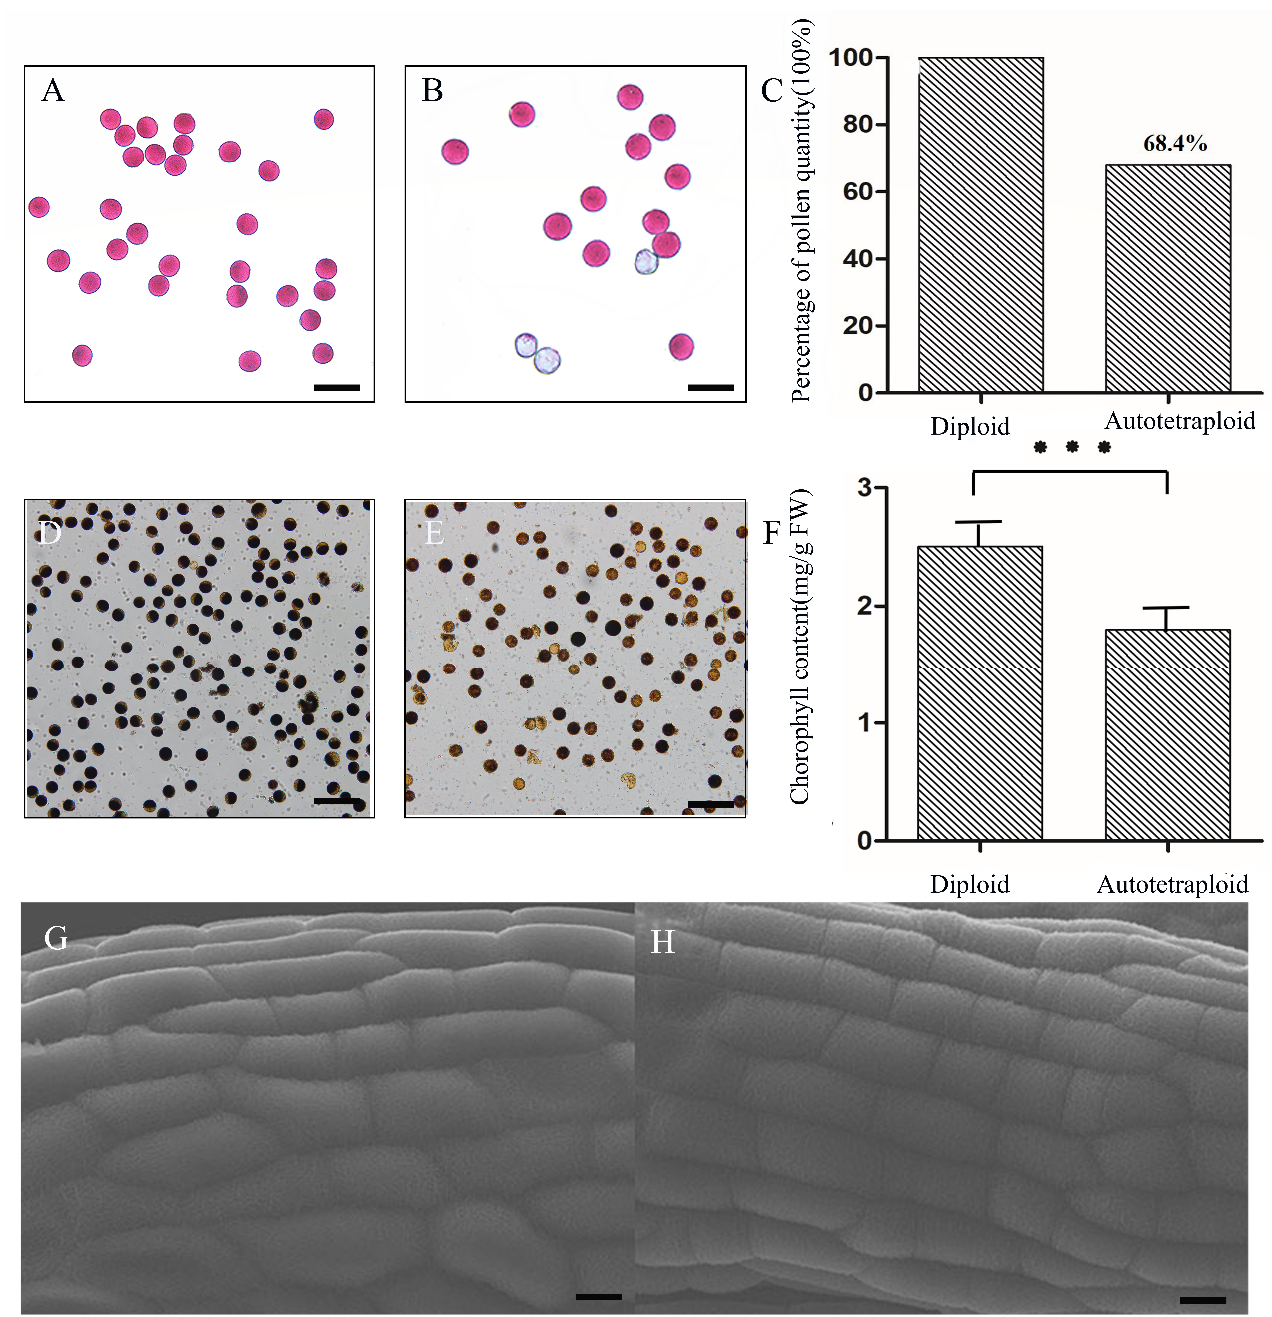
Figure 1. Fertility identification, chloroplast content determination, and anther ultrastructure observation. ( A , B ) Pollen grains subjected to Alexander staining; ( D , E ) pollen grains subjected to 1% iodine–potassium iodide staining. ( A , D ) Diploid; ( B , E ) autotetraploid; ( C ) bar charts showing percentage of mature pollen grains (number of mature pollen grains in diploid rice is taken to be 100%); ( F ) comparison of chlorophyll content, n = 6, p < 0.001 (The asterisk on the top indicates significant differences); ( G , H ) surface electron microscope images of anthers of diploid and autotetraploid rice during meiosis I; ( G ) diploid; ( H ) autotetraploid. Bar = 20 μm ( A – D ), 10 μm ( G , H ).